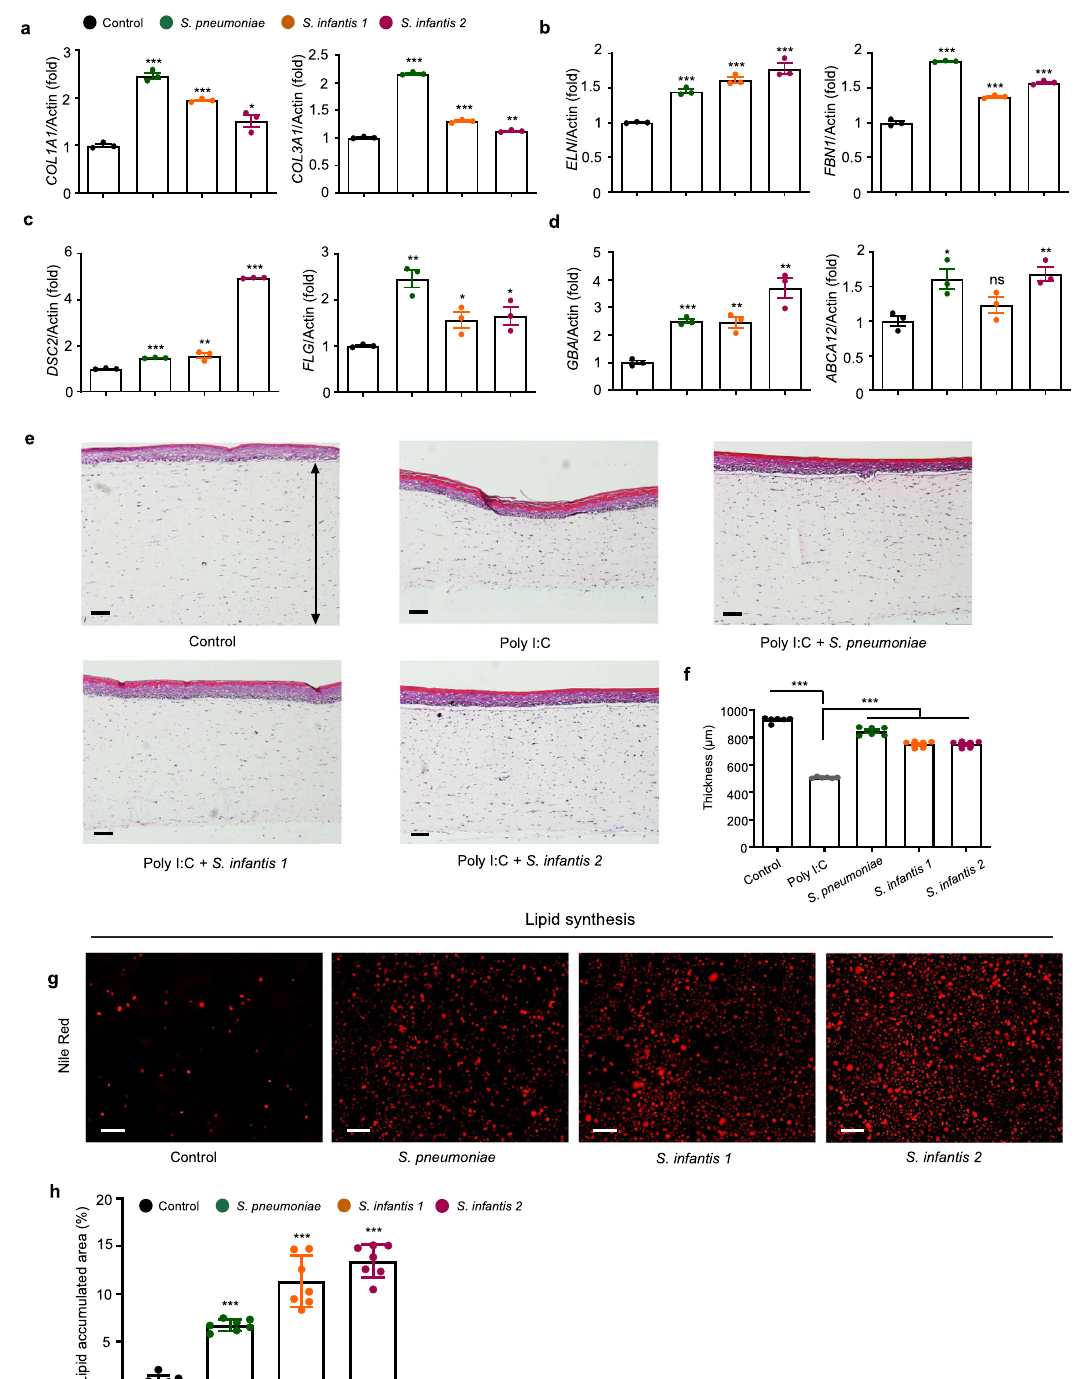
Fig. 2 Streptococcus growth media improve skin cells with various phenotypes. a – d Relative mRNA expression levels of a , collagen-associated genes important for elasticity in HDFs. b Elastic- fi ber – associated genes in HDFs, c tight-junction – associated genes important for skin barrier function and moisture in HEKs, and d lipid barrier-associated genes in HEKs. HDFs human dermal fi broblast, HEKs human epithelial keratinocytes. Expression values are relative to control cells and represent the mean ± S.E. Three technical replicates were done. COL1A1 collagen type l alpha 1 chain, COL3A1 collagen type lll alpha 1 chain, ELN elastin, FBN1 fi brillin 1, DSC2 desmocollin 2, FLG fi laggrin, GBA glucosylceramidase beta, ABCA12 ATP-binding cassette subfamily A member 12. e Micrographs of a skin cell layer in the control and after treatment with Poly I:C, Poly I:C and supernatant of S. pneumoniae , Poly I:C and supernatant of S. infantis 1 , and Poly I:C and supernatant of S. infantis 2 . 1 μ g/mL of Poly I:C was used in each treatment. Arrow line indicates the thickness of the epidermal layer. f Corresponding plot of the thickness of skin cell layer, n = 6. g Nile red staining of HEKs treated with different Streptococcus -cultured media. h Plot of area of lipid accumulations, n = 7. The Student ’ s two-tailed t -test was used to calculate statistical signi fi cance. * p < 0.05, ** p < 0.01, *** p < 0.001. ns non-signi fi cant. Scale bar corresponds to 100 μ m. Control is a non-treated